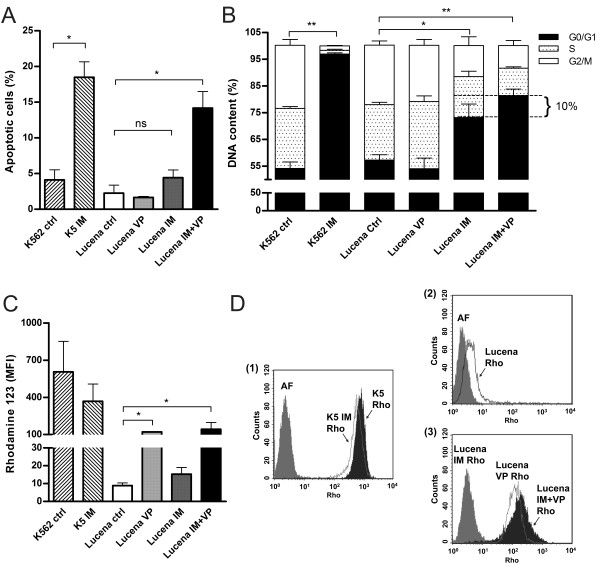
Lucena cells cross-resistance to IM is due Pgp efflux. Apoptotic cells (A), cell cycle (B) and Rho 123 (C-D) were measured by flow cytometry after 3 different treatments conditions: 1 μM IM, 50 μM VP and co-treatment with 1 μM IM and 50 μM VP. (D) Representative histograms of Rho 123 extrusion under conditions described above. (1): K562 ctrl and IM treatment; (2): Lucena ctrl and (3) Lucena under: IM, VP and IM + VP treatments. K562 cells were used as positive control for Rho 123 retention, and K562 treated with 1 μM IM was used as positive control for apoptosis induction and cell cycle arrest. Values represent the means of three independent determinations ± s.d. (*p < 0.05; **p < 0.01). AF = auto fluorescence; K5 = K562; LU = Lucena.